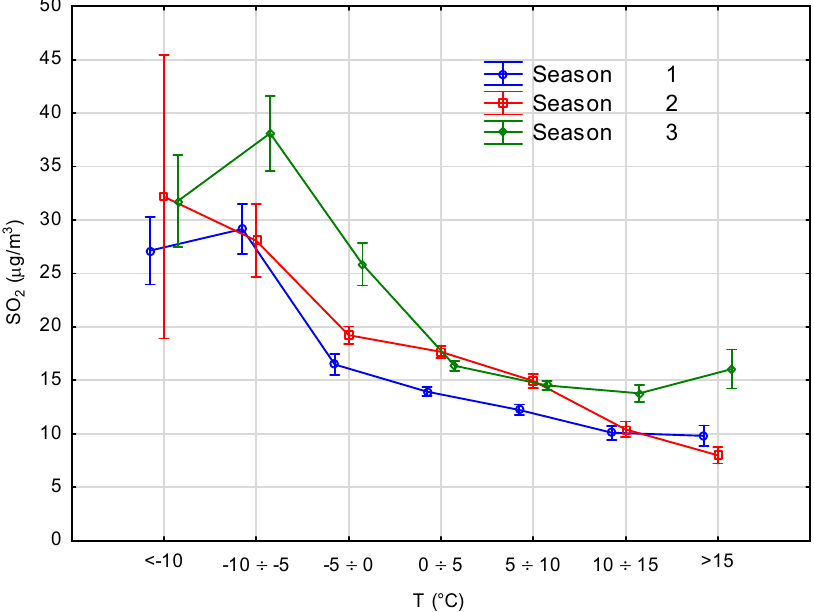
Figure 5. Relation between SO 2 concentration and temperature for the analyzed heating seasons.